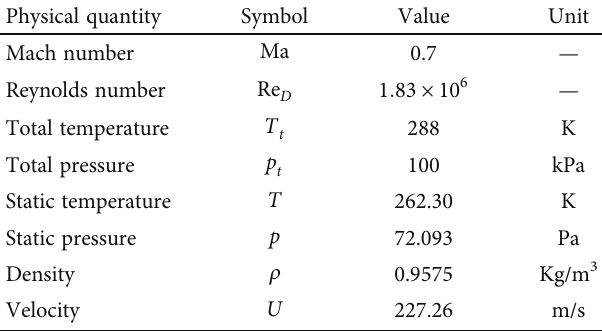
Table 2: Freestream fl ow